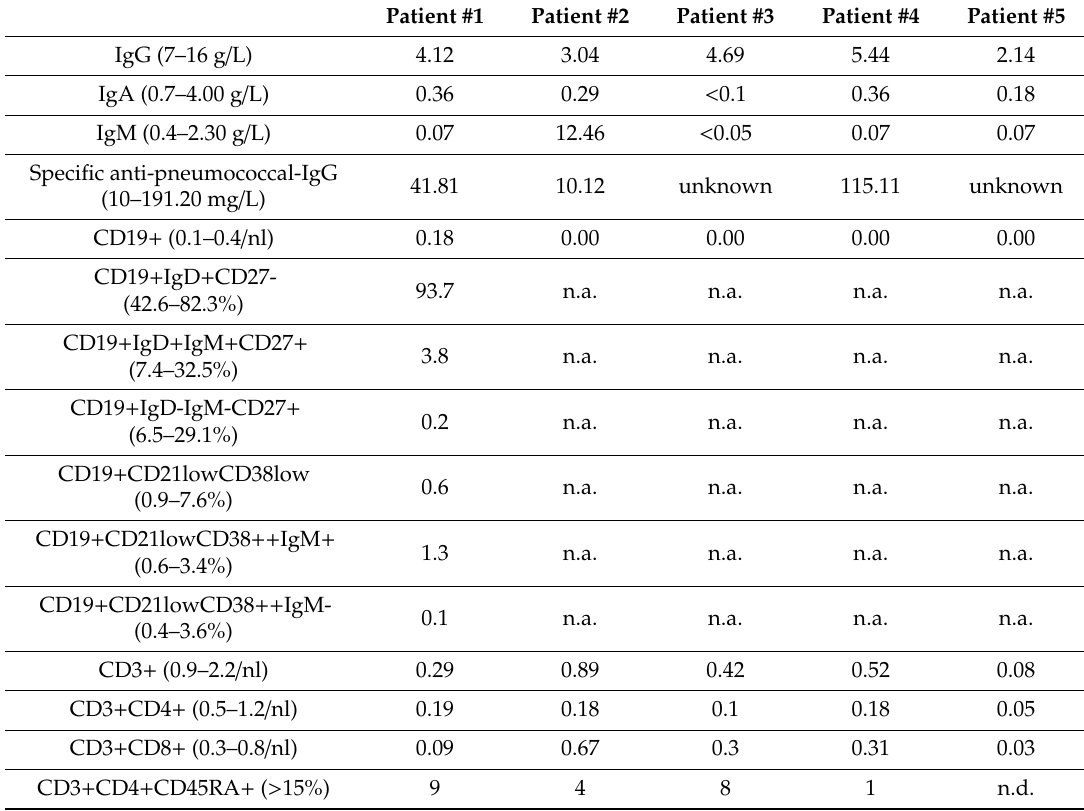
Table 3. Immunological parameters of the patient cohort.